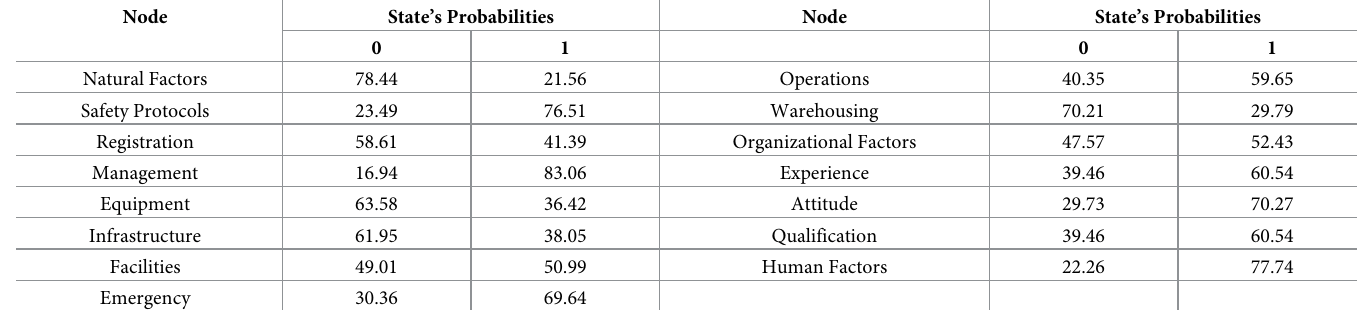
Table 2. Probabilities of the causation factors when evidence set at hazardous cargo environment and pollution accident to